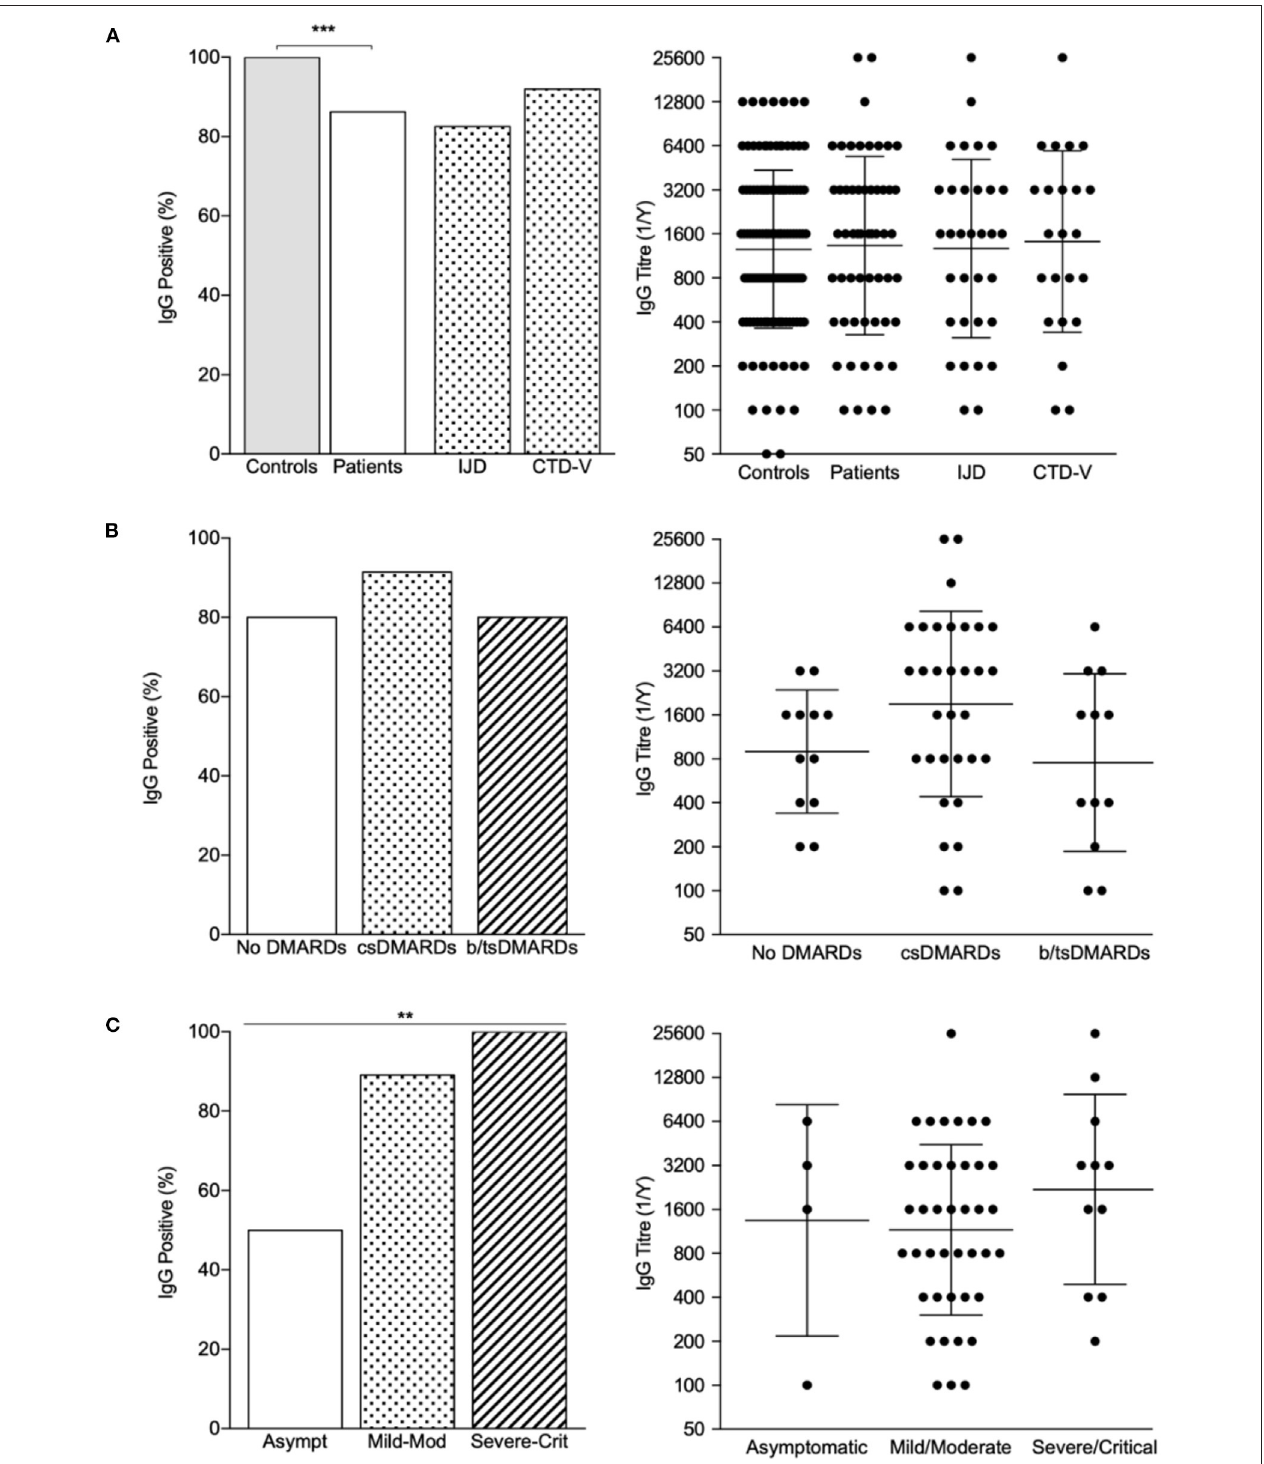
FIGURE 1 | IgG seroprevalence rates and titer distribution across patients and controls. (A) Proportion of IgG positive patients and IgG titers in controls and patients, with individualization per rheumatic disease type. *** P < 0.001. (B) Proportion of IgG positive patients and IgG titers across treatment classes; bars represent GMT ± GSD. (C) Proportion of IgG positive patients and IgG titers according to COVID-19 severity; bars represent GMT ± GSD. ** P < 0.01. b/ts, biological/targeted synthetic; cs, conventional synthetic; CTD-v, connective tissue diseases and vasculitis; DMARDs, disease modifying antirheumatic drugs; IJD, inflammatory joint diseases.